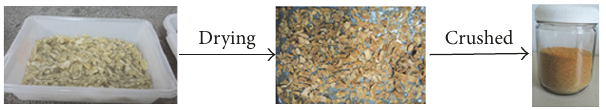
Figure 1: Steps to obtain the CBA